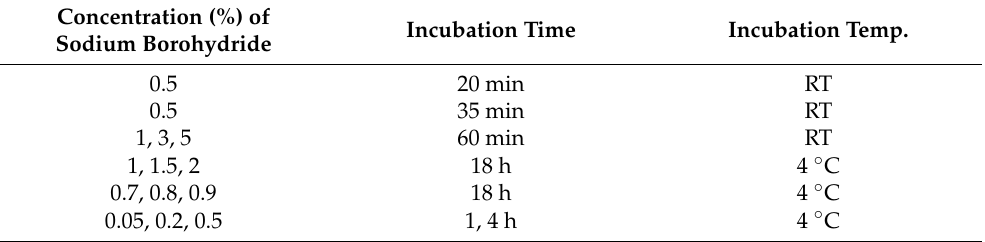
Table 2. Quenching conditions in Matrigel-embedded fixed cells using sodium borohydride. Concentration (%)